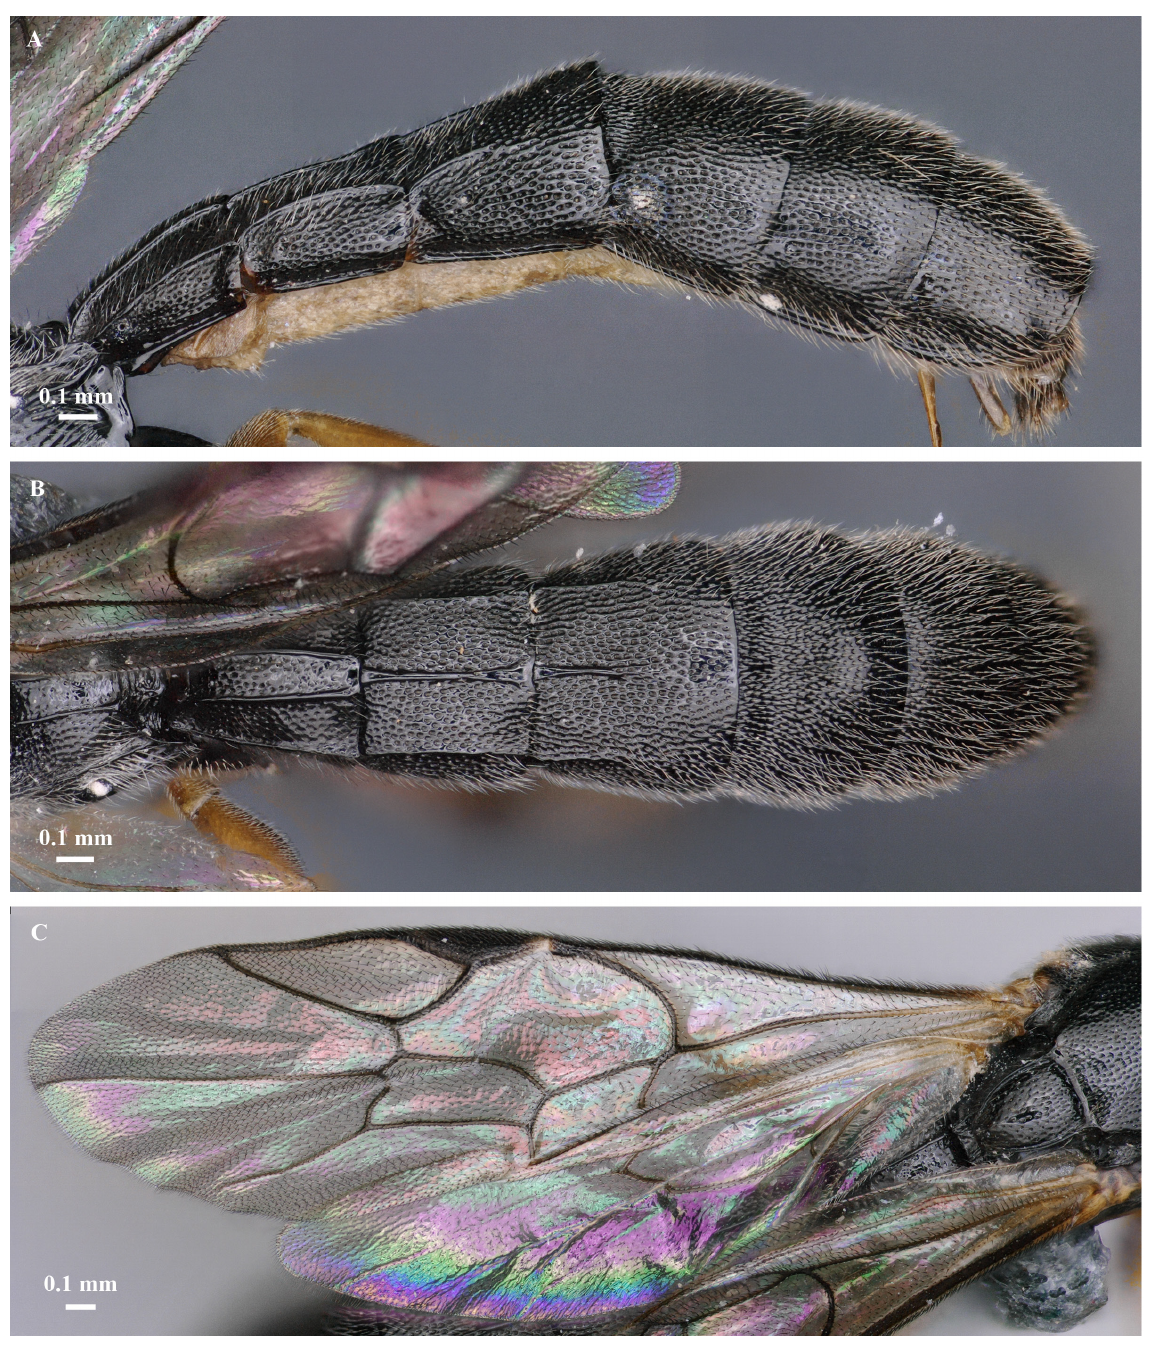
Fig. 6. Trieces orientalis sp. nov., holotype, ♀ (AIMB). A . Metasoma, lateral view. B . Metasoma, dorsal view. C . Fore